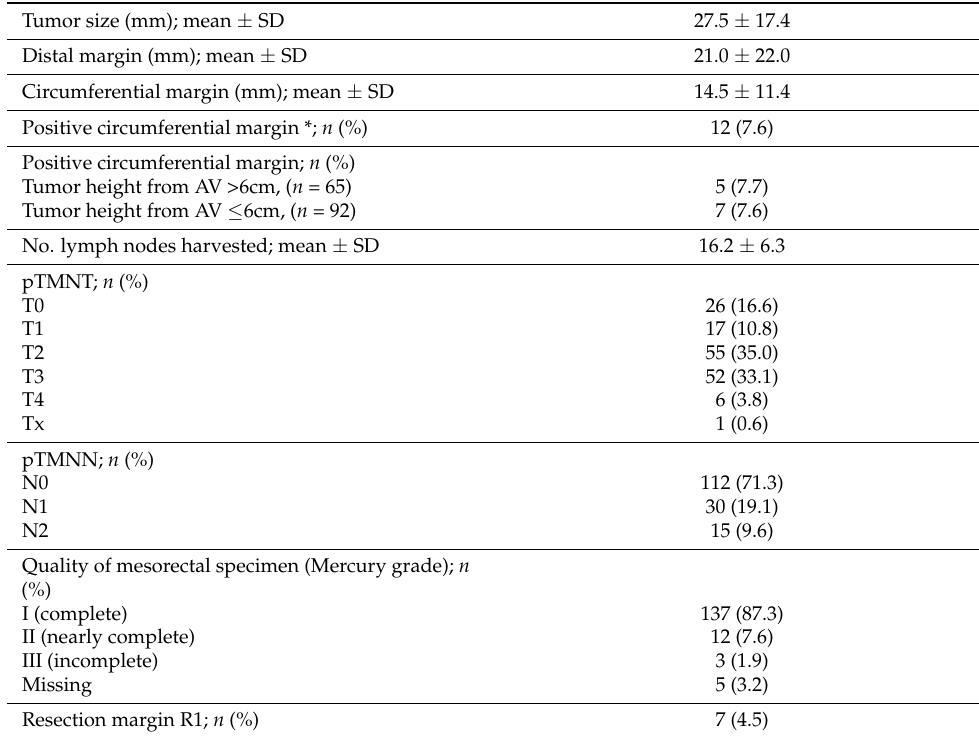
Table 4. Histopathological outcome ( n = 157).